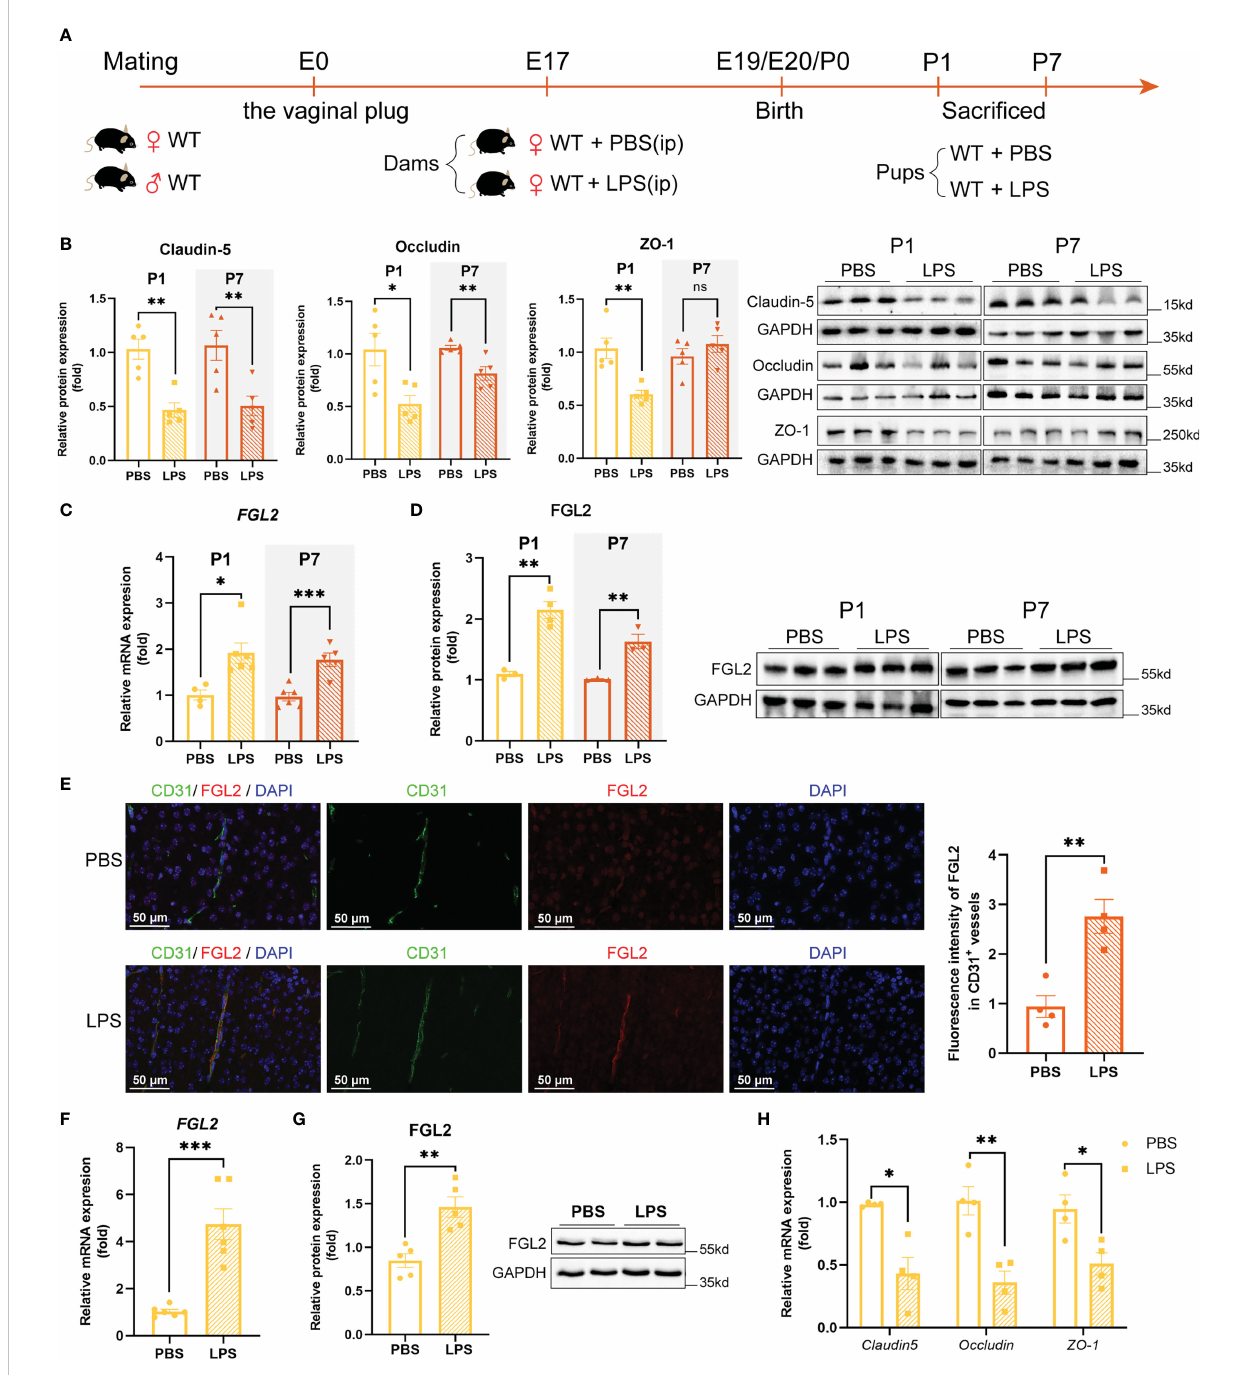
FIGURE 1 Increased endothelial expression of FGL2 was associated with the reduced TJ proteins. (A) Experimental scheme of WT mice. WT dams were randomly intraperitoneally injected with LPS (200 µg/kg) or PBS at E17. Pups were sacri fi ced and their brains were collected at P1 and P7. (B) The protein expressions of Claudin-5, Occludin, and ZO-1 in brain at P1 and in cortex at P7 ( n = 5). (C) The mRNA levels of FGL2 in brain at P1 and in cortex at P7 ( n = 4:6:6:5). (D) The protein expressions of FGL2 in brain at P1 and in cortex at P7 ( n = 3:4:3:3). (E) FGL2 expression in CD31+ vessels by immuno fl uorescence staining in cortex at P7. The fl uorescence intensity of FGL2 in CD31+ vessels was analyzed by the ImageJ software and normalized to controls ( n = 4). Representative images and quantitative results were shown. Scale bar=50 m m. (F) The mRNA levels of FGL2 in BMECs ( n = 6). BMECs were treated with LPS (5 m g/ml) or PBS for 24h. (G) The protein expressions of FGL2 in BMECs ( n = 5). (H) The mRNA levels of Claudin-5, Occludin, and ZO-1 in BMECs ( n = 4). The data was expressed as mean ± SEM and was the representative of at least three independent experiments. Statistical comparisons were assessed by unpaired two-tailed Student ’ s t test. ns P >0.05, * P <0.05, ** P <0.01, *** P